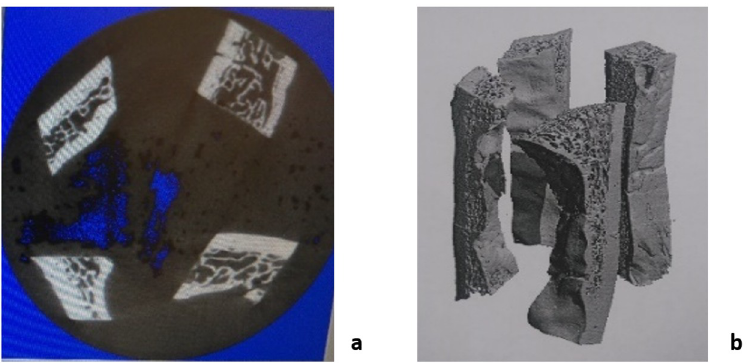
Fig 3. Sample arrangement for microCT scans. a) Cross-section image of the samples during the scan (midsection). b) 3D rendering of the scanned samples.